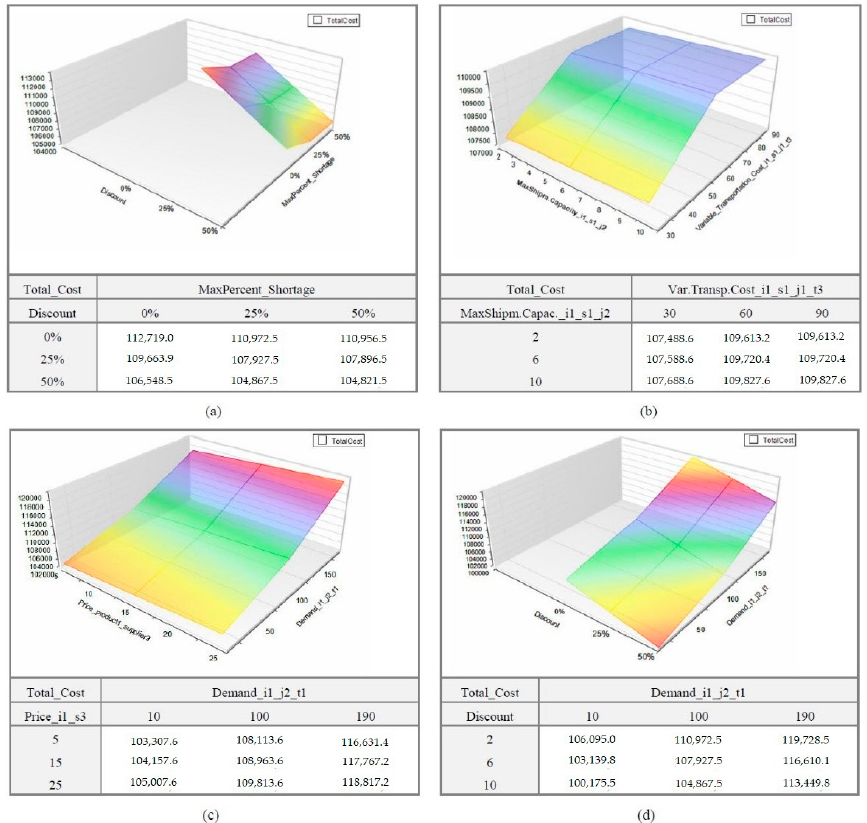
Figure 7. Graphs and related reports of the optimal solution obtained by varying two parameters independently, i.e., ( a ) “Discount” and “Max_Percent_Shortage”, ( b ) “Max_Shipm.Capac._i1_s1_j2” and “Var.Transp.Cost_i1_s1_j1_t3”, ( c ) “Price_i1_s3” and “Demand_i1_j2_t1”, ( d ) “Discount” and